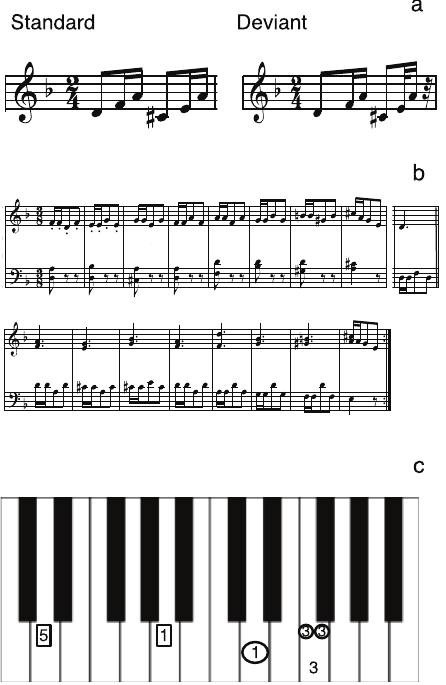
Figure 1. Stimulus material. (a) Tone sequences for the standard and the deviant stimuli that were used in the MEG measurements before and after training. (b) Musical score of the training piano melody. The first line is repeated after the end of the second line. The measure at the end of the first line concludes the melody. (c) Visual templates for the SA training. Numbers represent the fingers (thumb, 1; index finger, 2 and so on) with which the subjects were supposed to press the corresponding piano keys. The rectangles indicate that the left hand is used, the circles mark the right hand. The numbers that were depicted in one horizontal line had to be played simultaneously. The small circles indicated that notes had to be played at double speed.